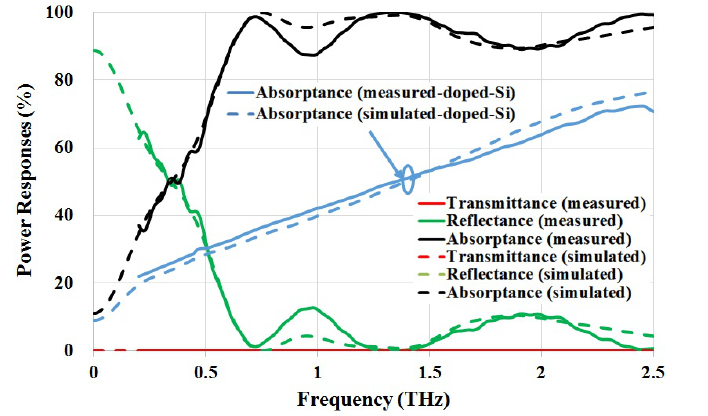
Figure 7. Measured power responses for the proposed THz absorber and doped silicon